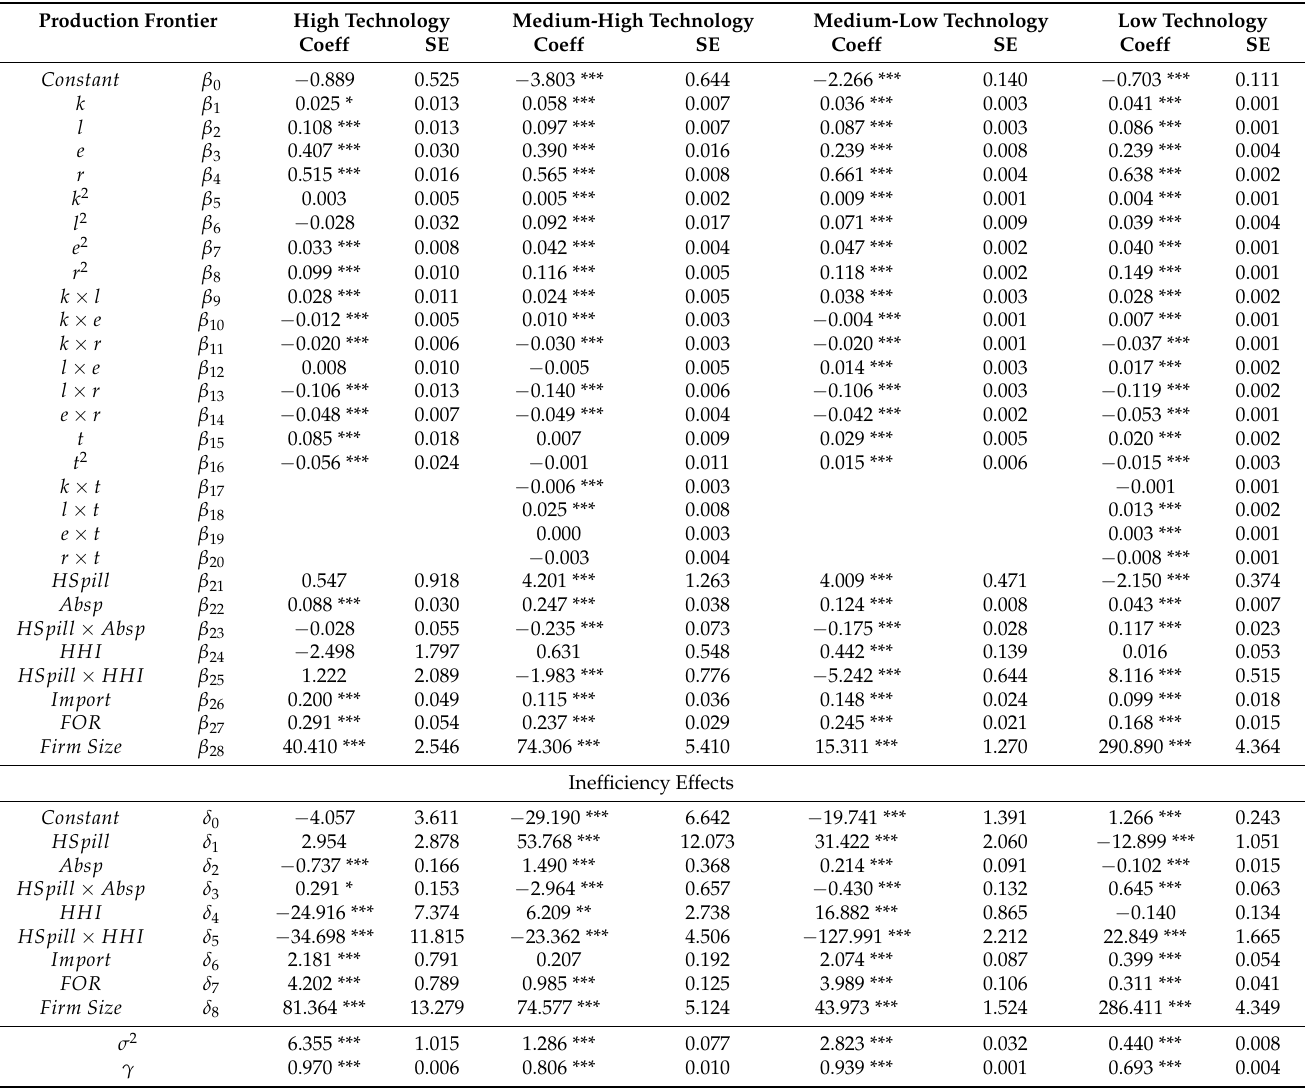
Table A1. Estimation of production function and inefficiency effects for all technology